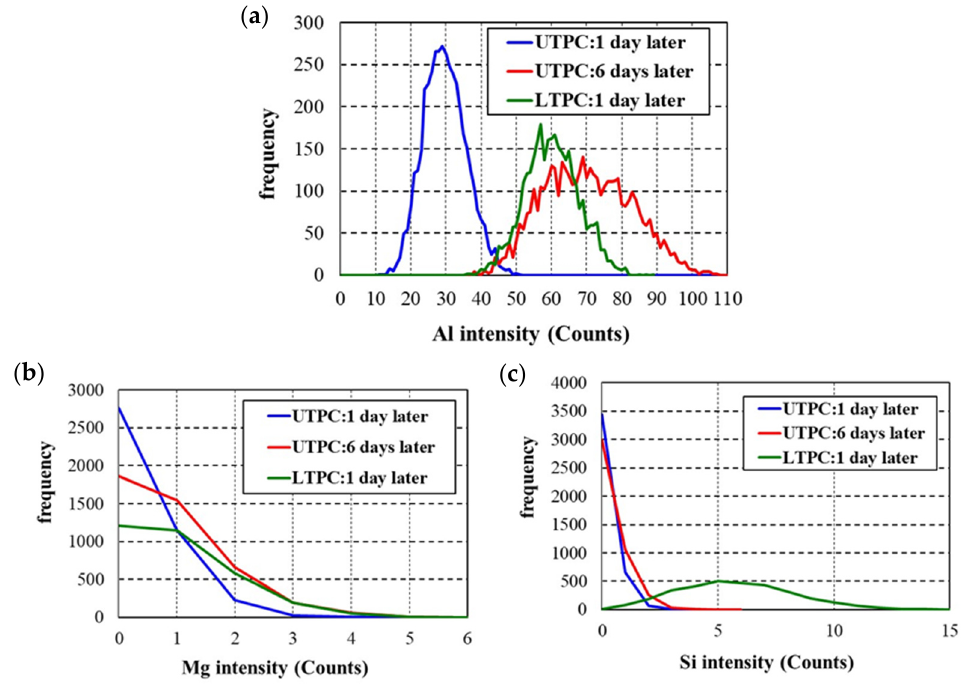
Figure 8. Frequency distribution of Mg and Si concentrations obtained from SEM-EDS line analysis 6 days after UTPC processing: ( a ) Al; ( b ) Mg; ( c ) Si. (WJ: 35 MPa, UC: 800 W, 20 min).